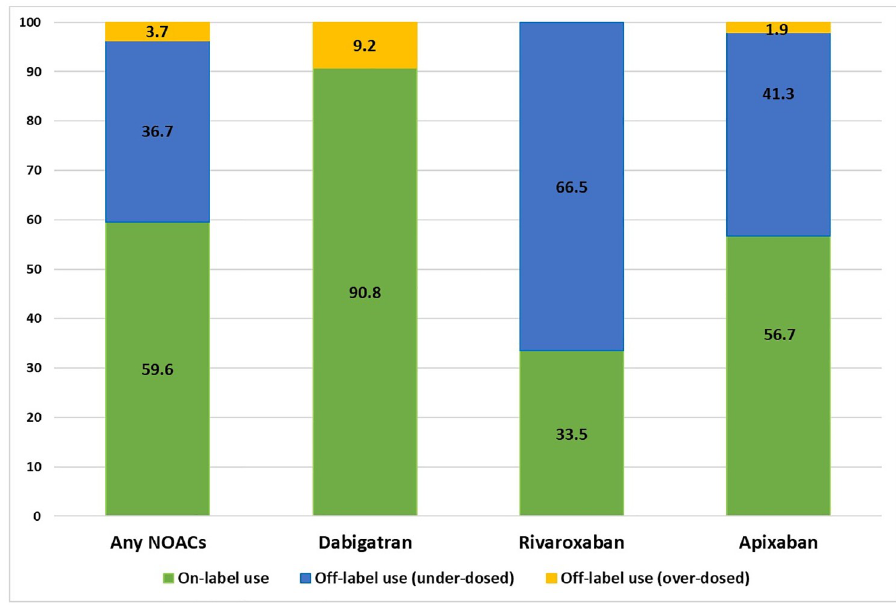
Fig 3. Proportion of NOACs dosing according to label.